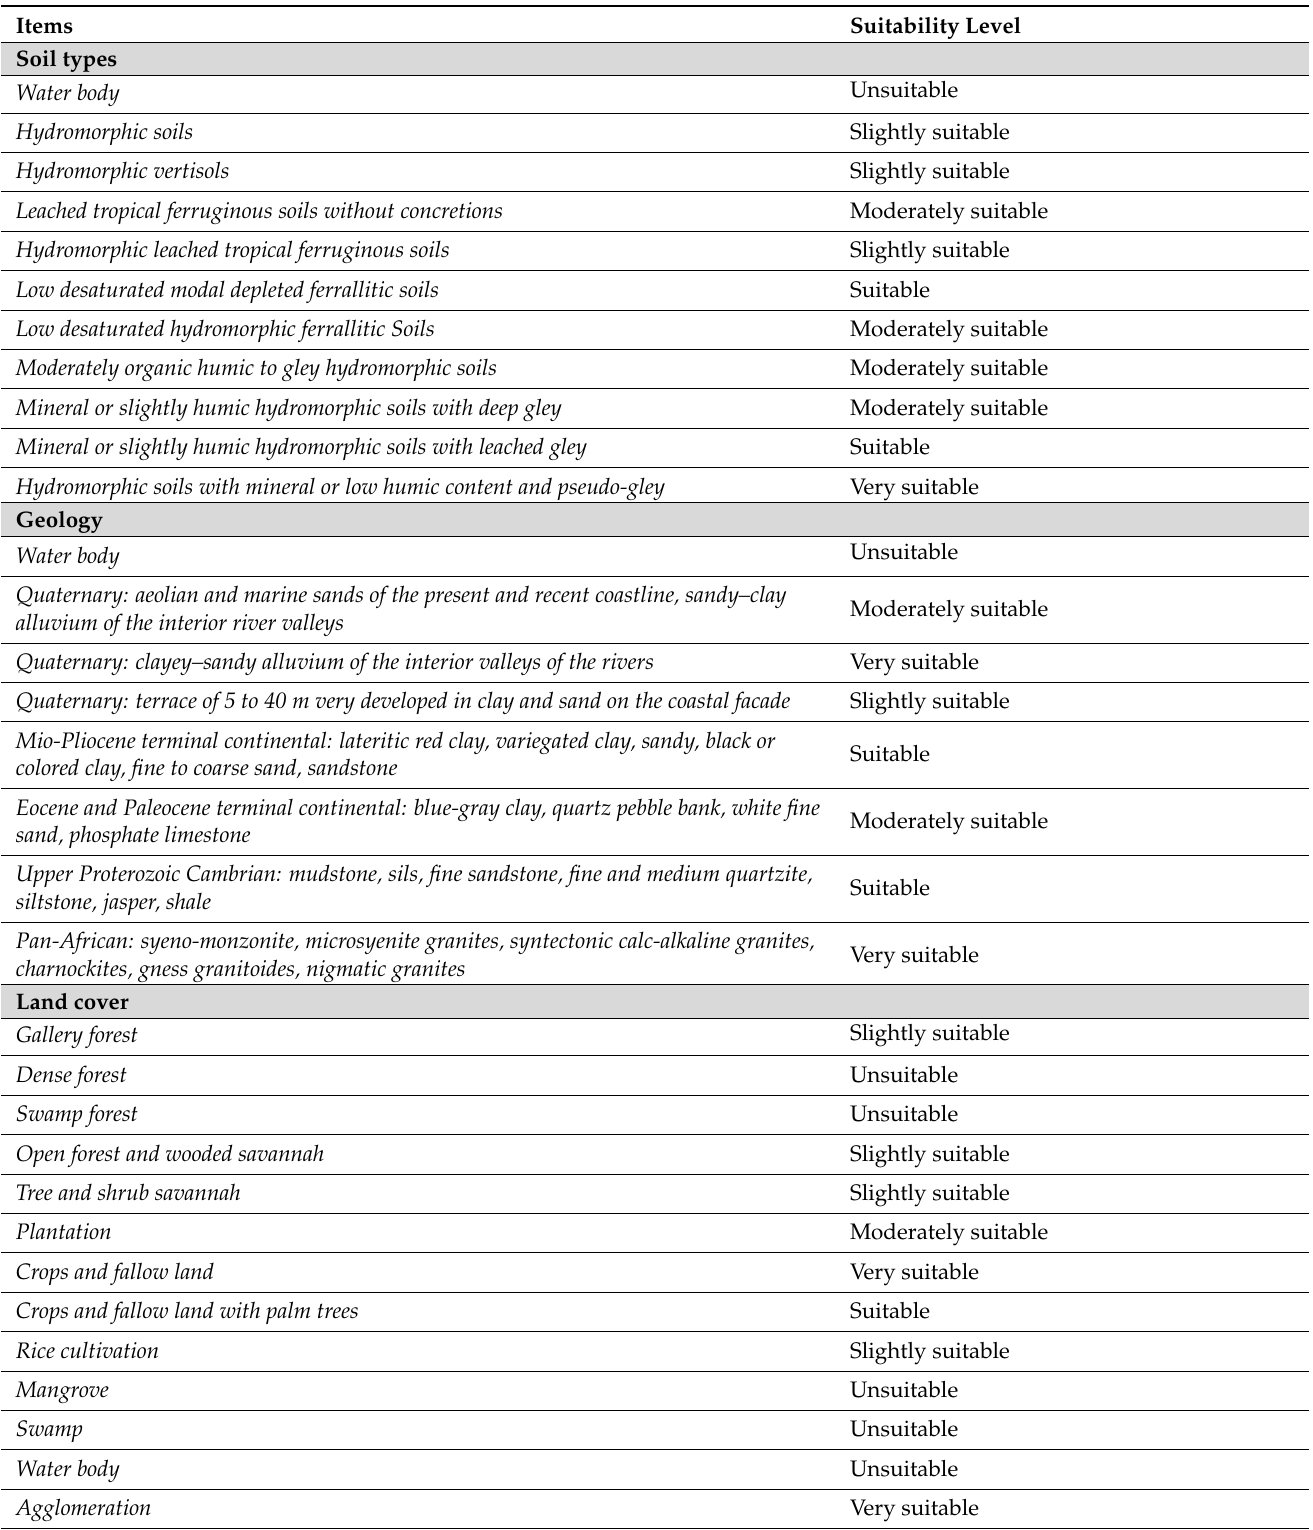
Table 3. Evaluation of soil, geological and land-use